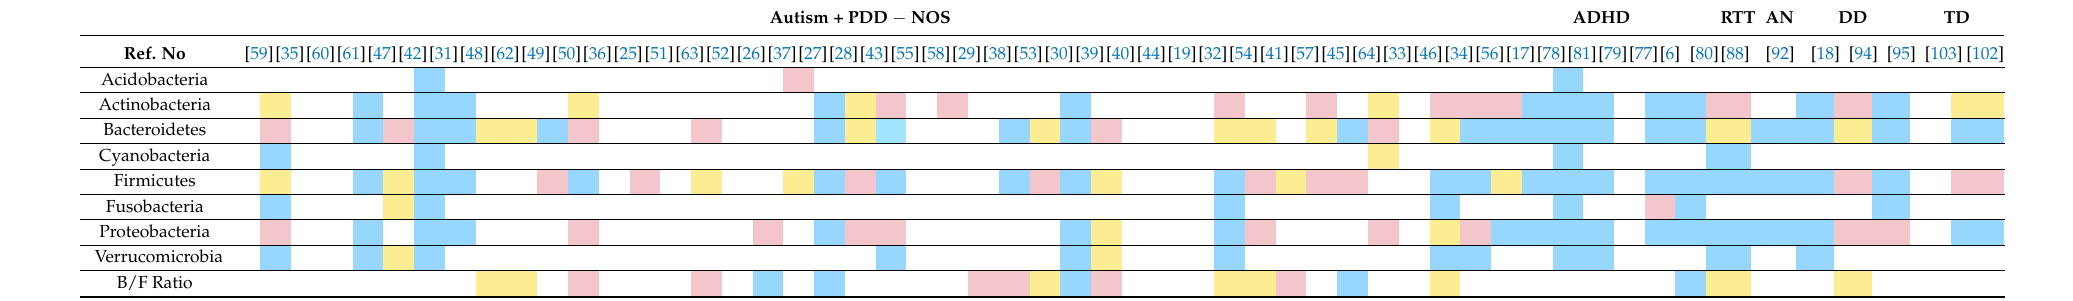
Table 2. Bacterial composition differences in children and adolescents with psychiatric disorders—phylum level. Autism + PDD − NOS ADHD RTT AN DD TD